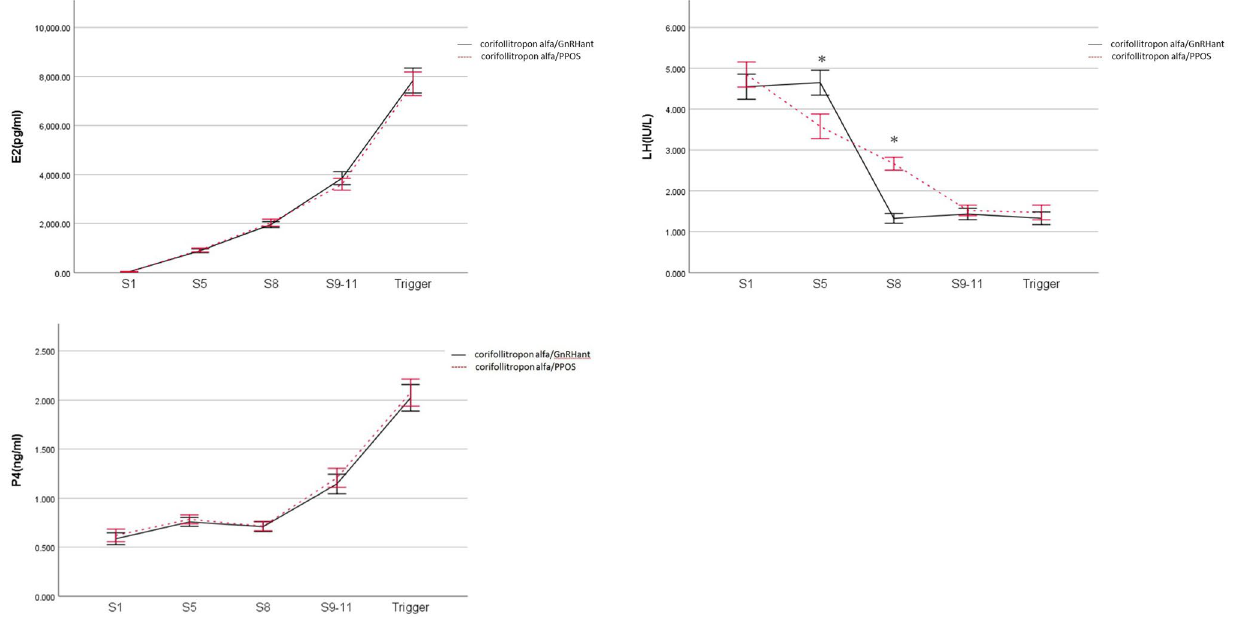
Figure 2. Serum hormone profiles during controlled ovarian stimulation in the two protocols. The solid black lines represent the corifollitropin alfa/GnRHant protocol, and the dashed red lines represent the corifollitropin alfa/PPOS protocol. The values were expressed as mean and standard deviation. The asterisk (*) represents P < 0.05 at time point. S1 stimulation day 1, Trigger ovulation trigger